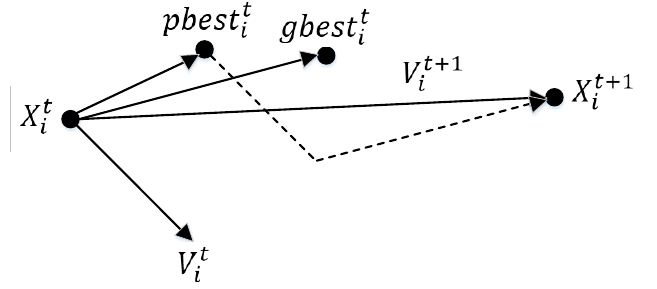
Figure 3. Updating the position of a particle vector.